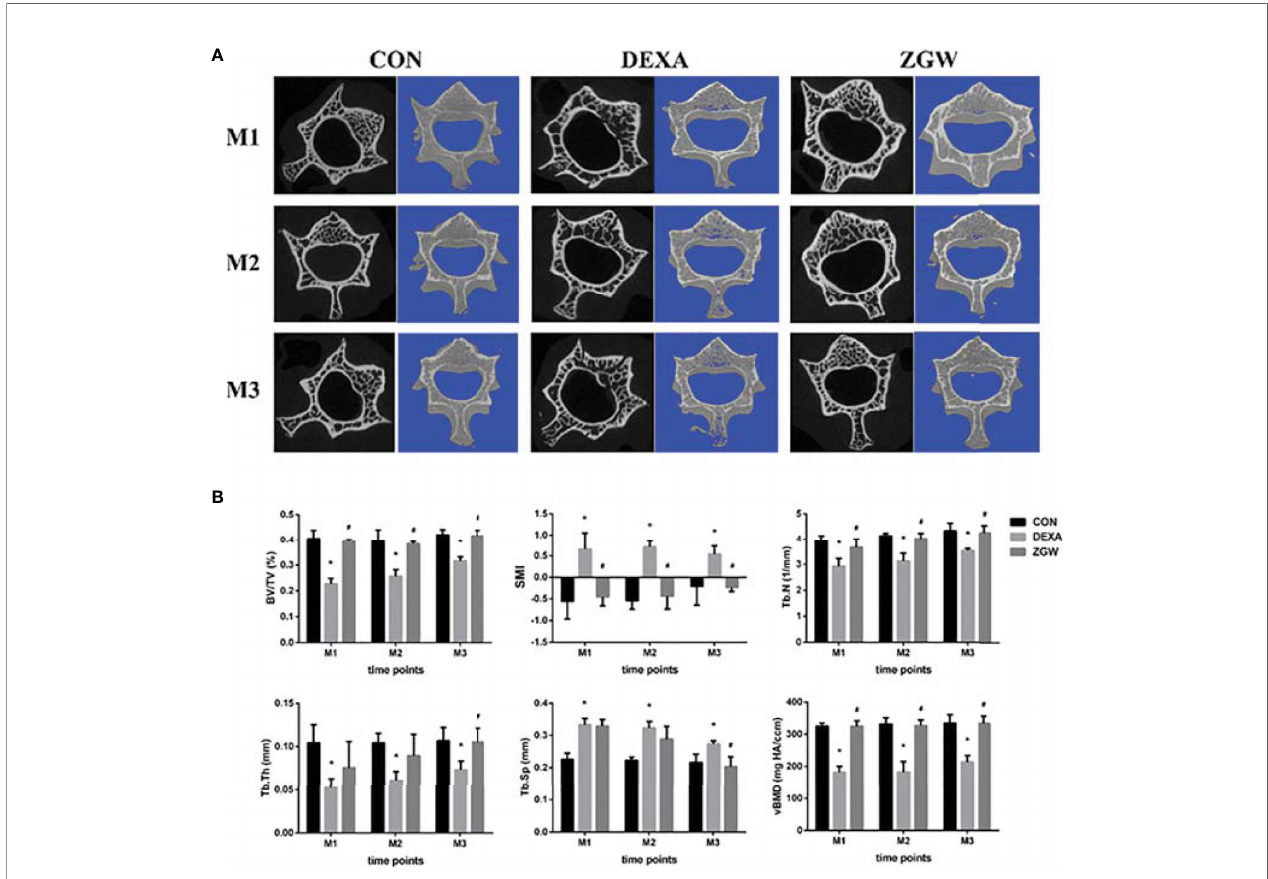
FIGURE 1 | Effects of ZGW on bone microarchitecture and parameters determined by micro-CT. (A) Representative 2D and 3D micro-CT images. (B) Bone microarchitecture and parameters BV/TV, SMI, Tb.Th, Tb.N, Tb.Sp, and vBMD were calculated based on micro-CT results. Values are the means ± SD. * p < 0.05 vs. CON group; # p < 0.05 vs. DEXA